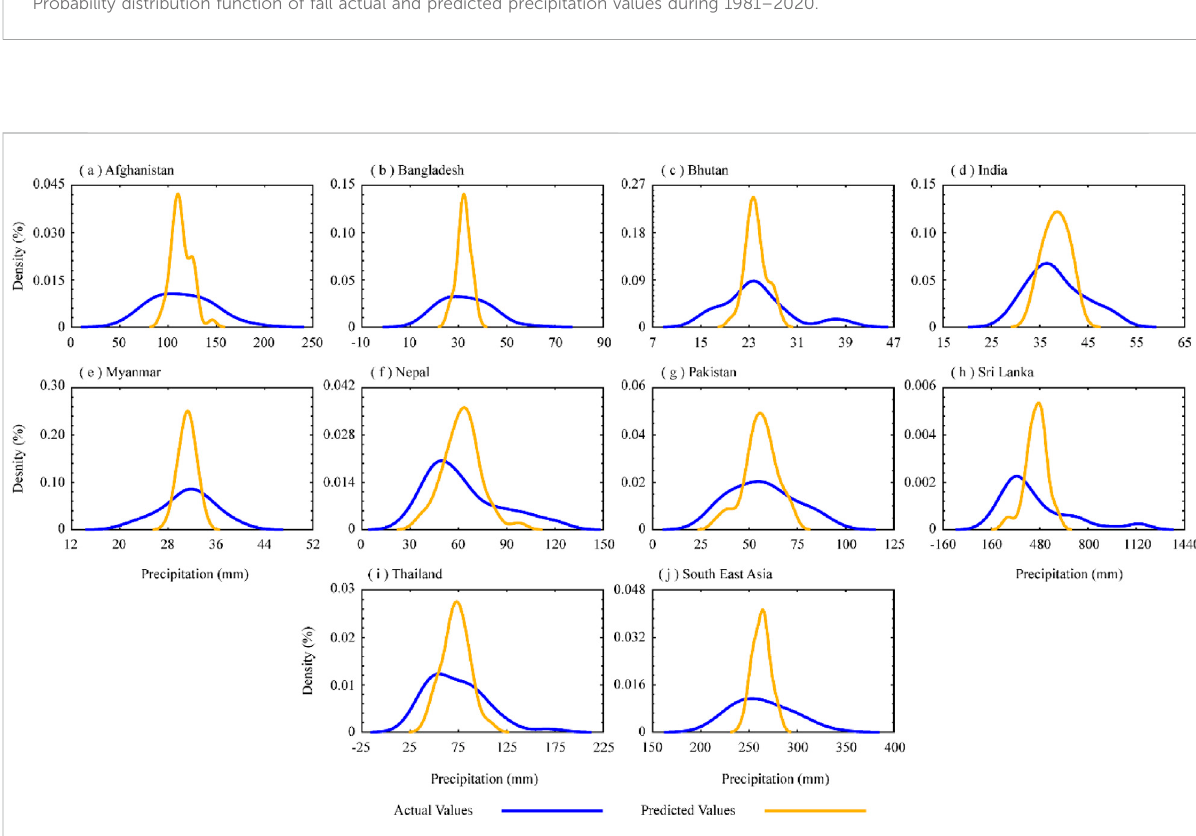
FIGURE 13 Probability distribution function of winter actual and predicted precipitation values during 1981 –